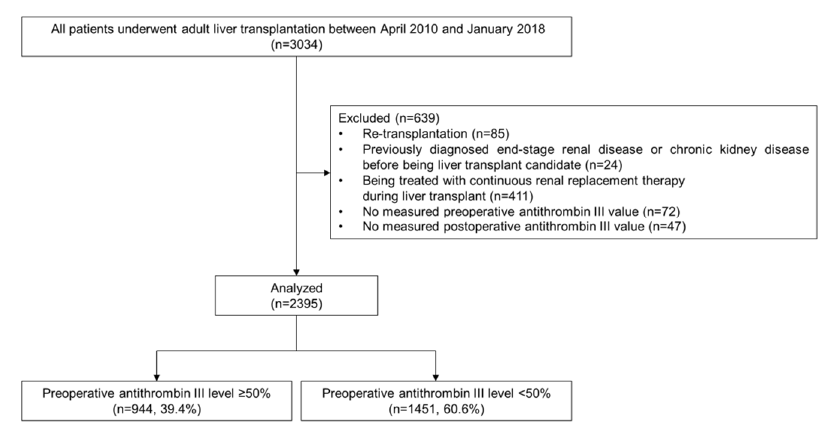
Figure 1. Flow diagram of the patient inclusion and exclusion.